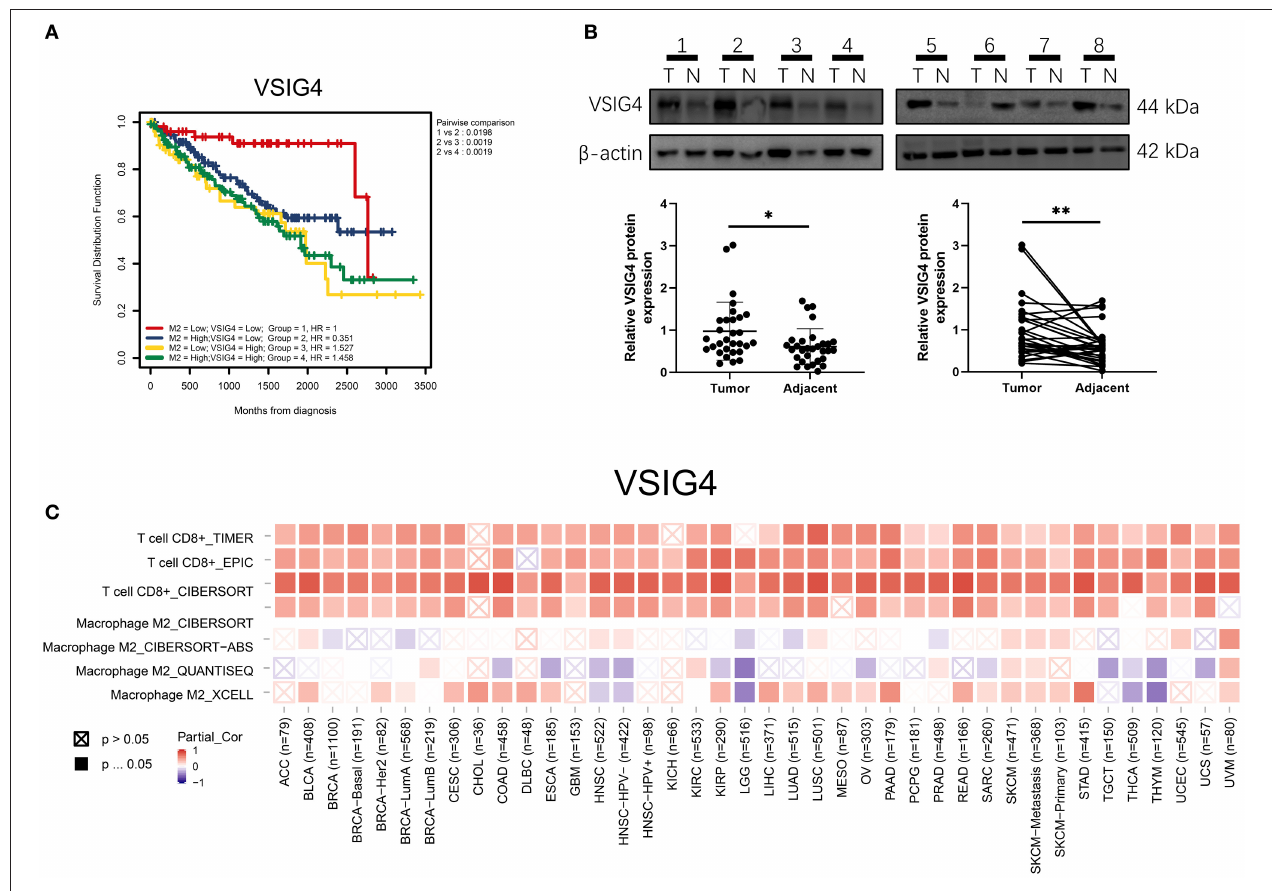
FIGURE 9 | (A) Combining high VSIG4 and high M2 macrophage showed more survival risk than the other group. (B) The VSIG4 protein expression levels were higher in clear renal cell carcinoma tissues than in normal tissues according to western blotting. (C) Pan-cancer analysis of VSIG4 in TCGA.